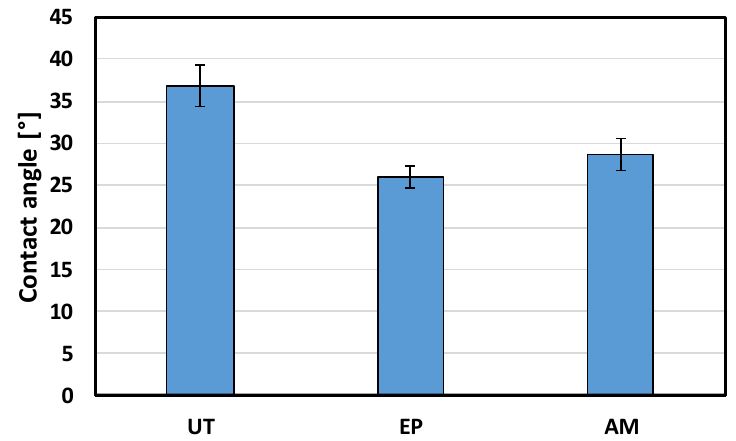
Figure 6. Contact angle between epoxy resin and PA12-CR substrates .